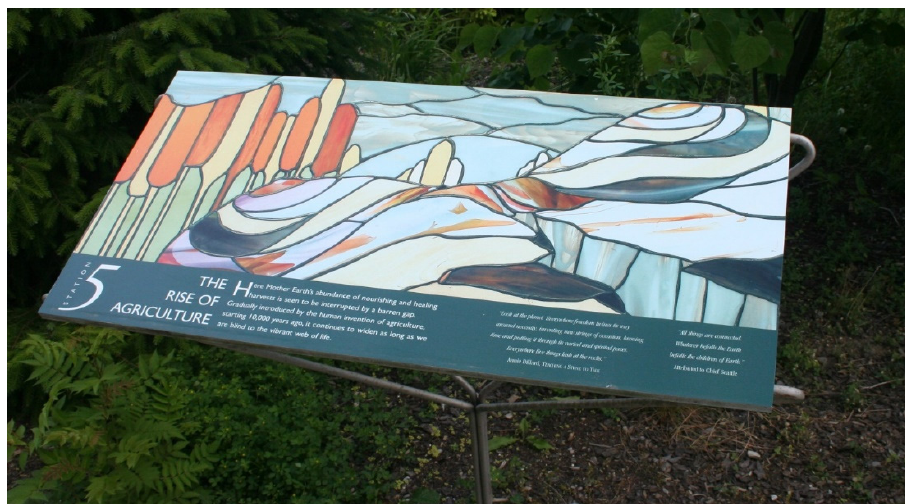
Figure 19. View of the 5th Station of the cosmic earth depicting the rise of agriculture.